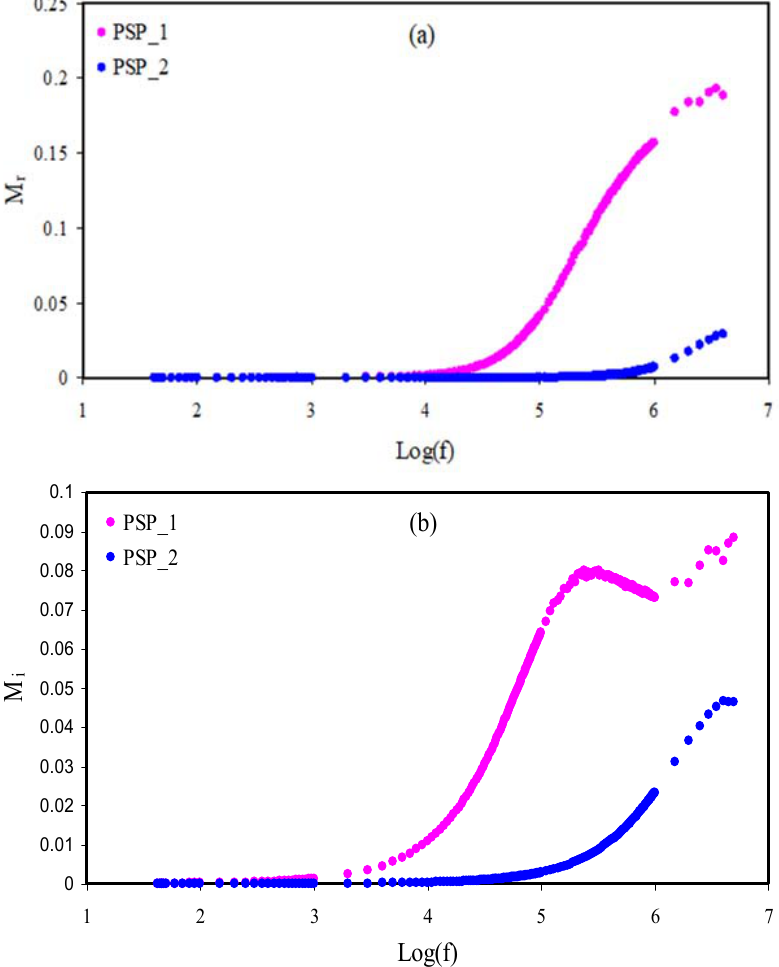
Figure 6. Electric modulus of ( a ) M r v log(f) and ( b ) M i v log(f) for pure PVA film at RT.